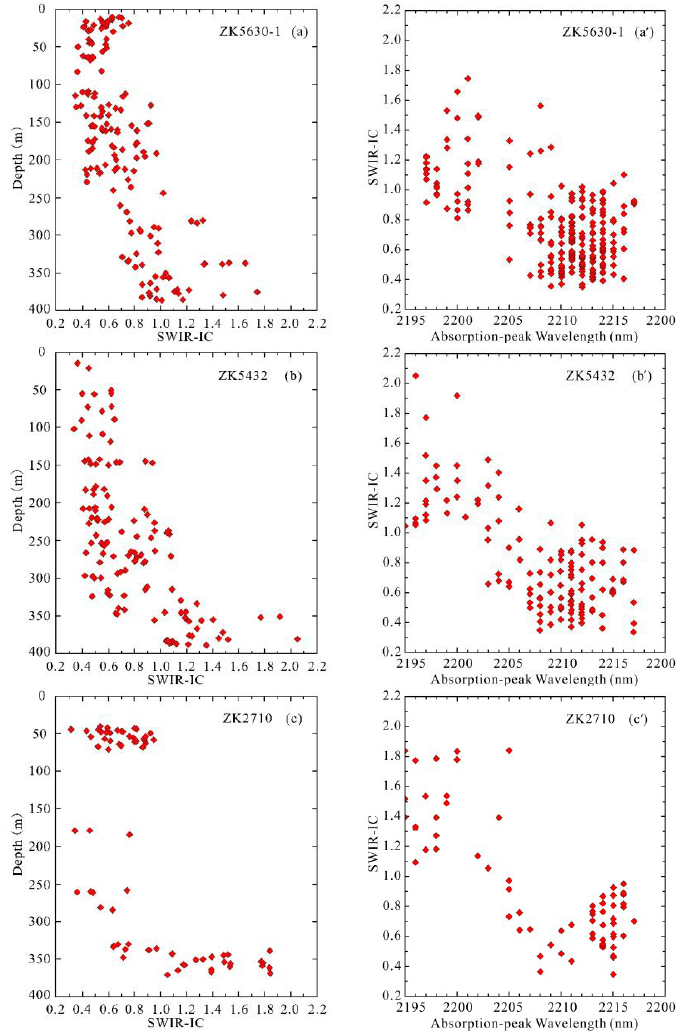
Figure 10. ( a – c ) SWIR-IC (1000–2500 nm) versus depth for drill holes ZK5630-1, ZK5432 and ZK2710, respectively. ( a’ – c’ ) SWIR-IC (1000–2500 nm) versus the absorption-peak wavelength of illite at 2200 nm for drill holes ZK5630-1, ZK5432 and ZK2710, respectively.